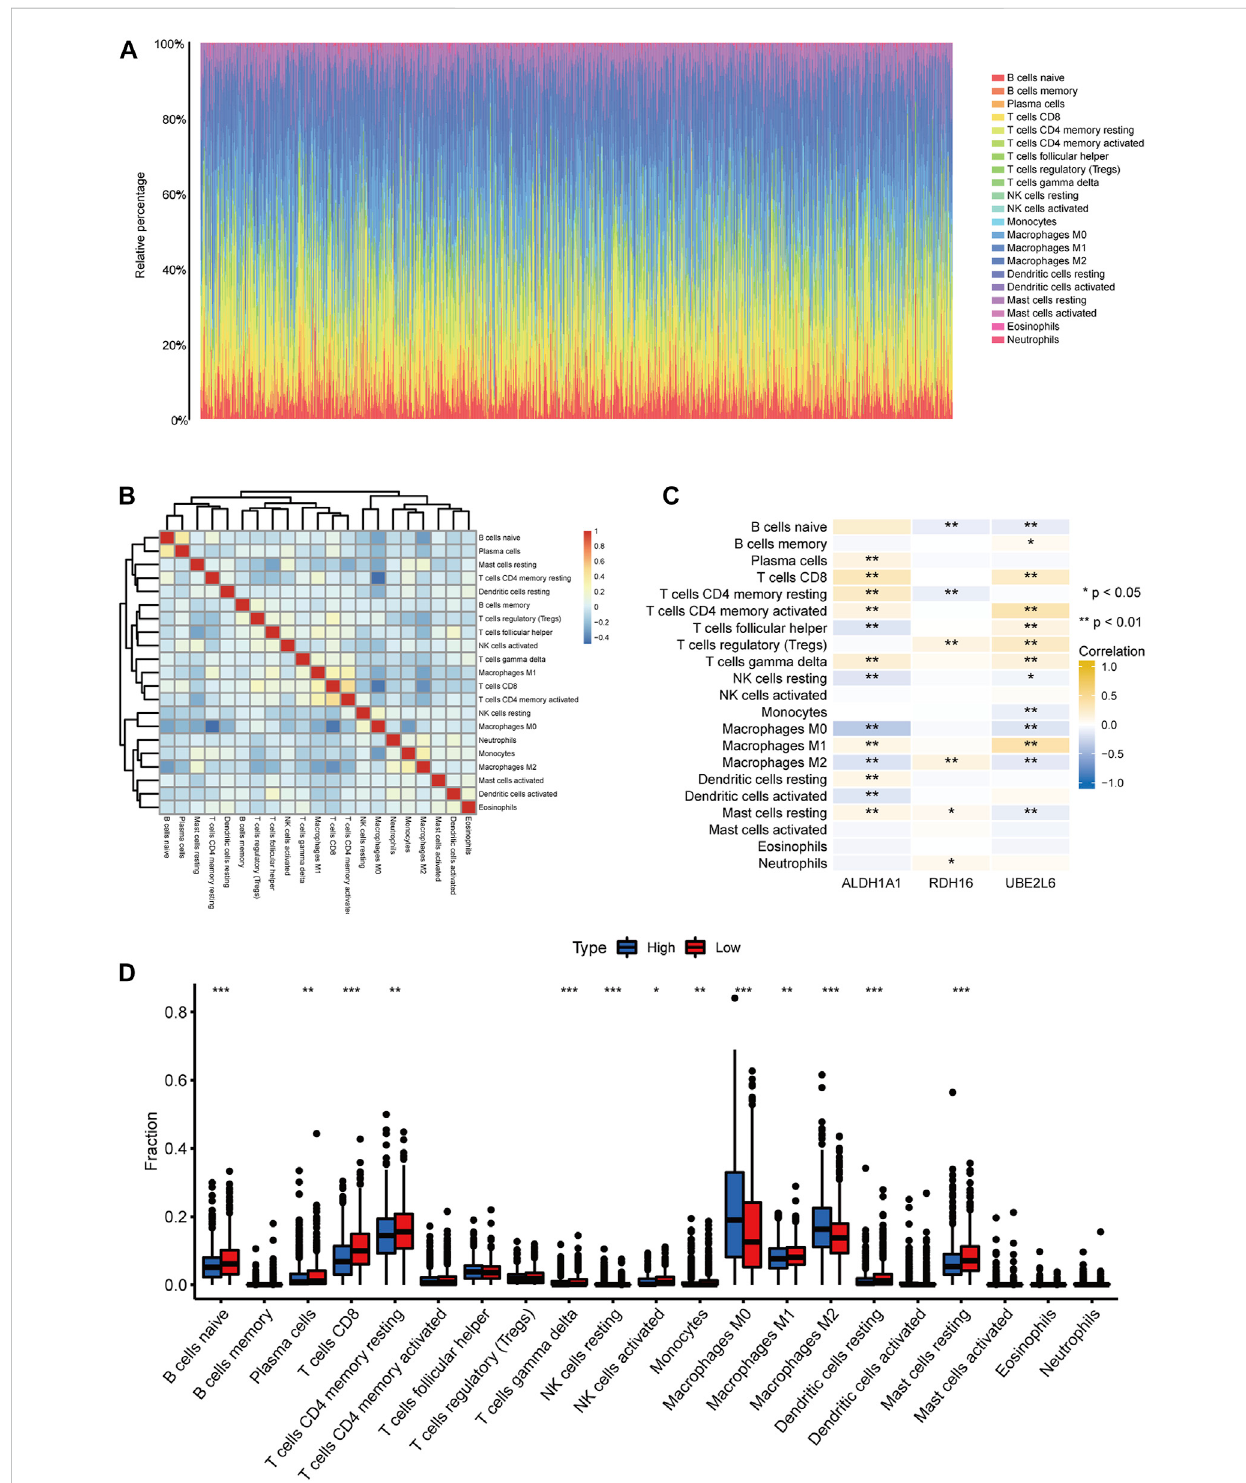
FIGURE 11 Immune in fi ltration analysis. (A) Abundance of immune cells in breast cancer samples. (B) Correlation heatmap of immune cells in breast cancer samples. (C) Correlation heatmap between differentially expressed fatty acid metabolism-related genes and immune cell in fi ltration levels. (D) Abundance of immune cells in high- and low-prognostic risk groups in breast cancer. (ns, p ≥ 0.05; *, p < 0.05; **, p < 0.01; ***, p <